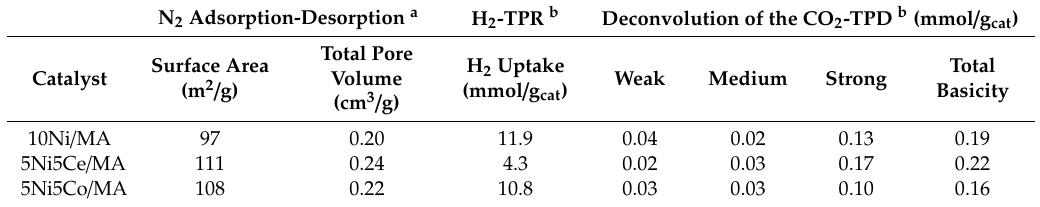
Figure 2. Nitrogen adsorption–desorption isotherms including the corresponding pore size distribution curves (inset) of 10Ni/MA, 5Ni5Ce/MA, and 5Ni5Co/MA catalysts. Table 1. The properties of 10Ni/MA, 5Ni5Ce/MA, and 5Ni5Co/MA catalysts.